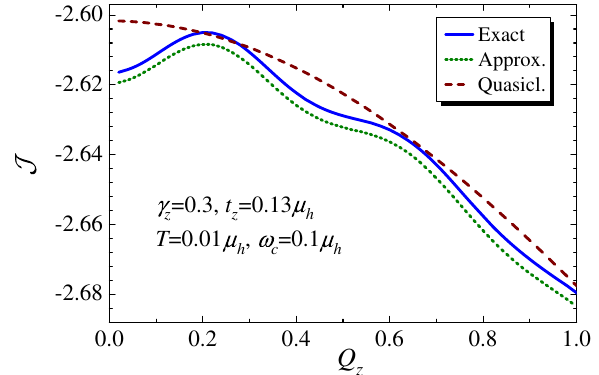
FIG. 6. Comparison of the representative Q exact total kernel eigenvalue J , Eq. (12), with quasiclassical formula, Eq. (13), and with the approximation which accounts for the oscillating correction, Eq. (14), to the quasiclassical result. The used parameters are shown in the